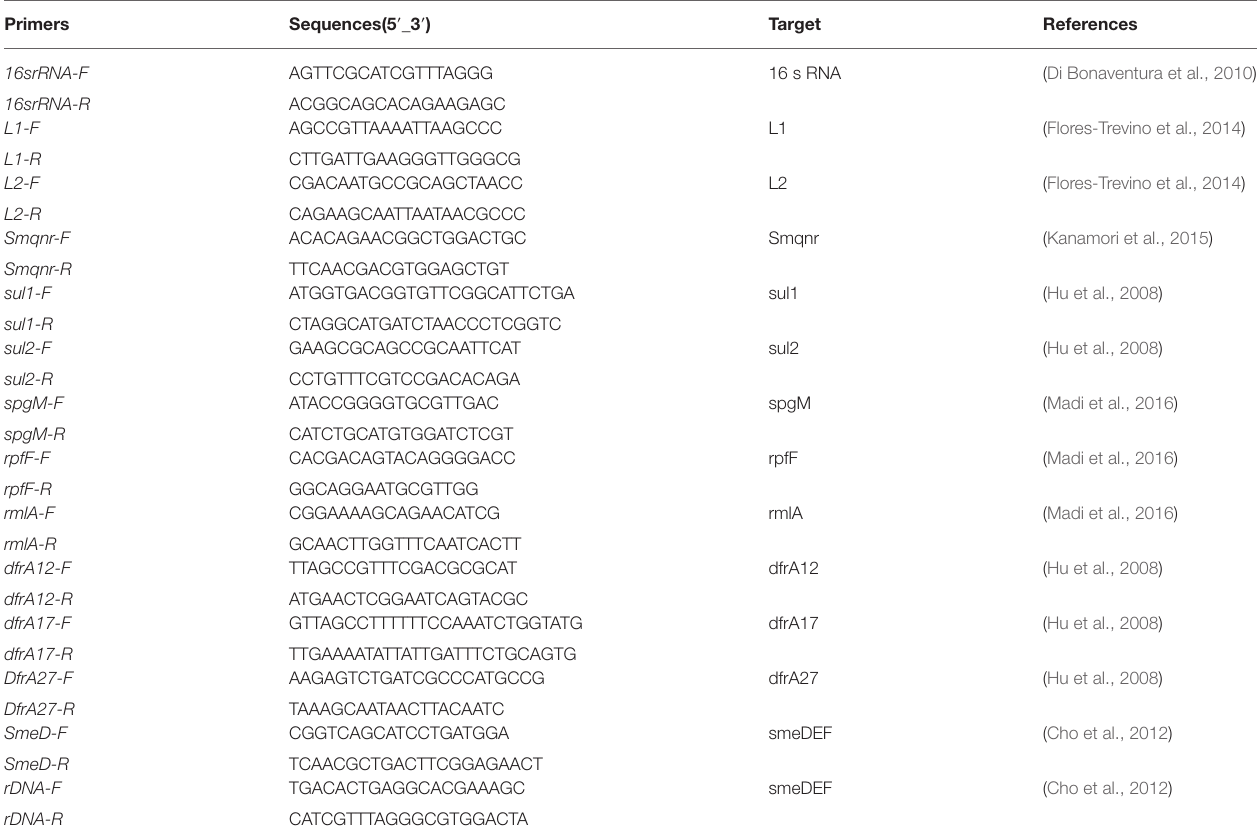
TABLE 1 | Oligonucleotide primers used in this